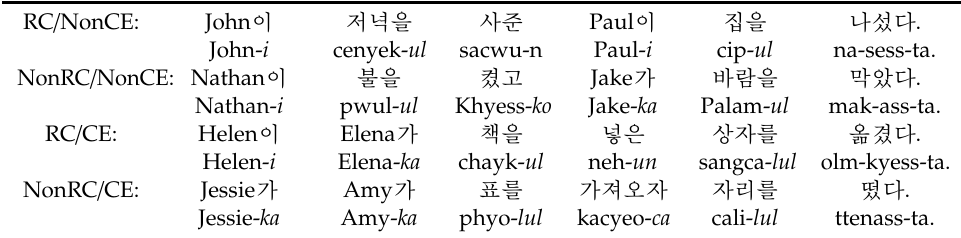
Table 1. Examples of sentences in Figure